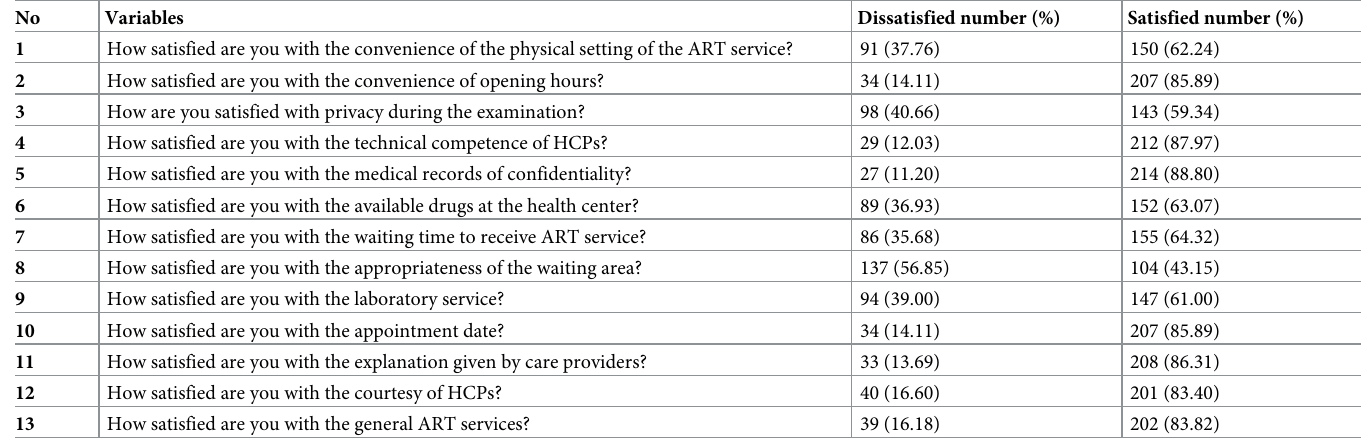
Table 5. Caregiver satisfaction on the ART service provided in GCAHCs, April